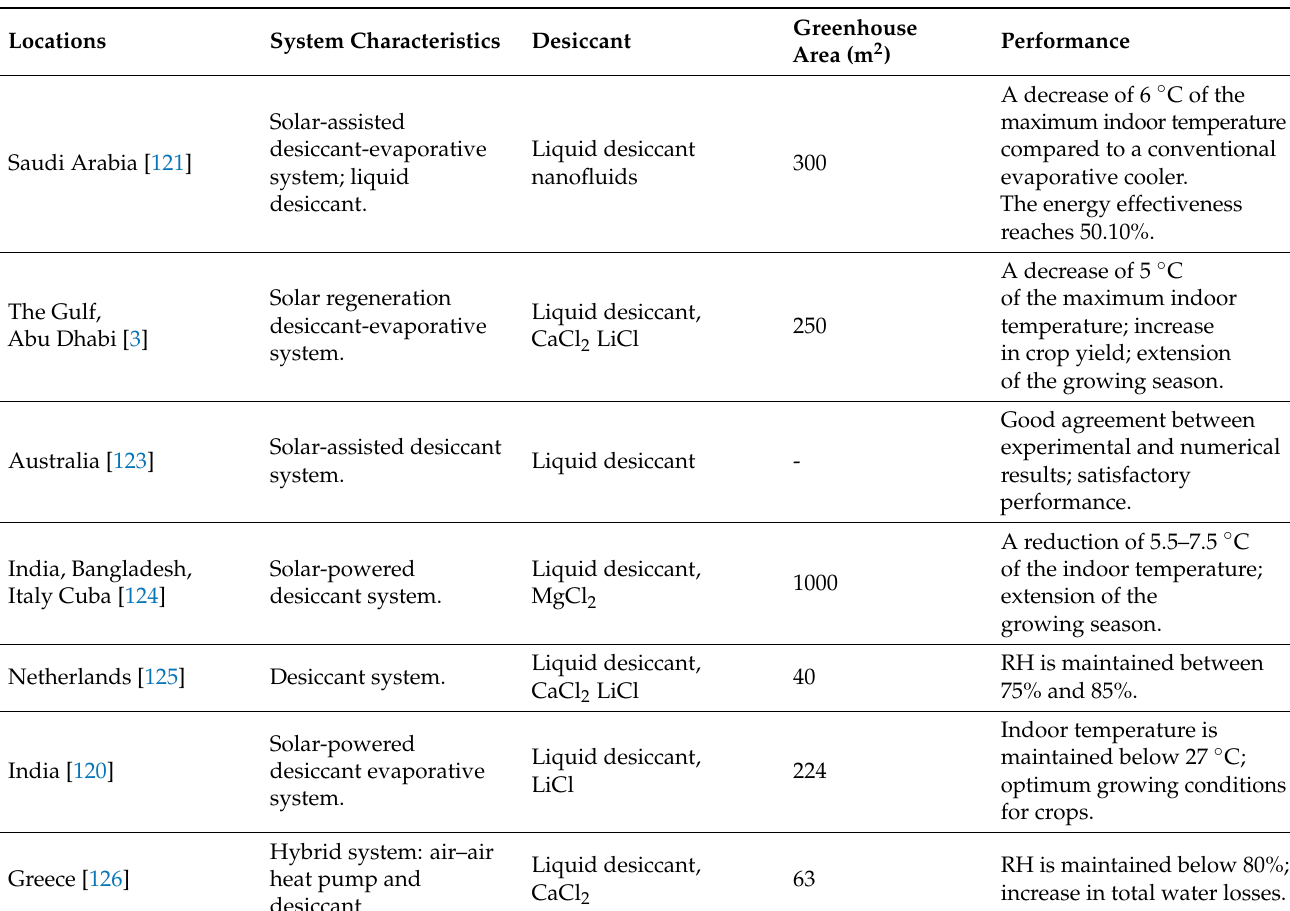
Table 4. Summary of studies of desiccant systems in